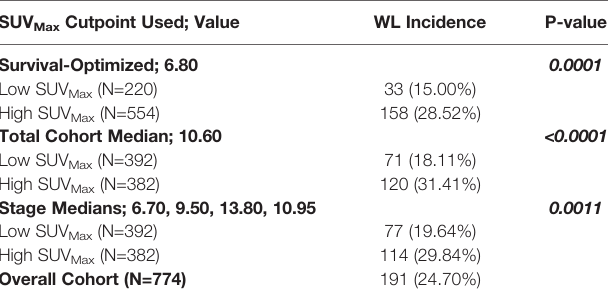
TABLE 3 | Incidence of Signi fi cant Pretreatment Cancer-Associated Weight Loss (WL) by High and Low SUV Max Determined by Experimental Cutpoints. SUV Max Cutpoint Used;